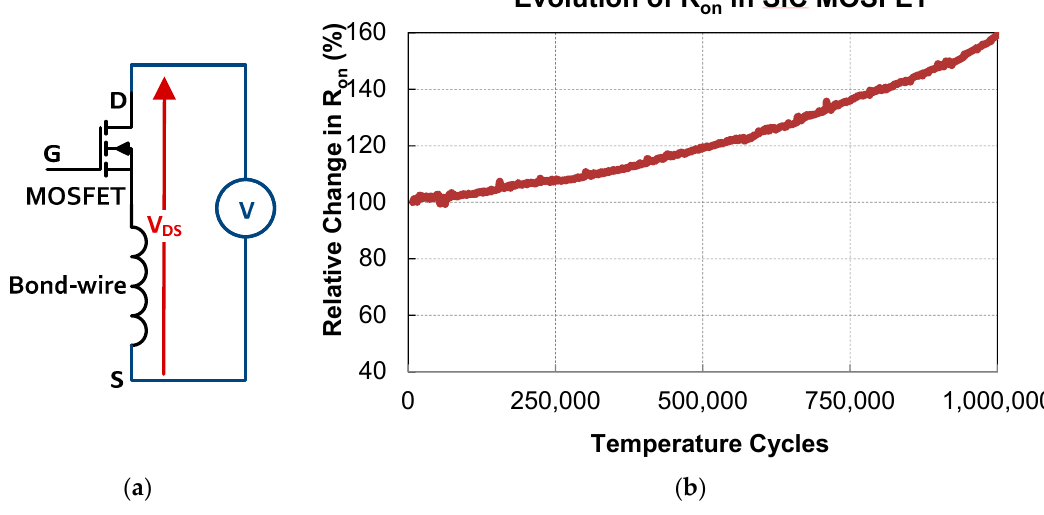
Figure 2. ( a ) Measurement of the voltage drop across a MOSFET; ( b ) Evolution of on-state resistance (R on ) of a Silicon Carbide (SiC) MOSFET in TO-247 packaging during an accelerated aging test [17].